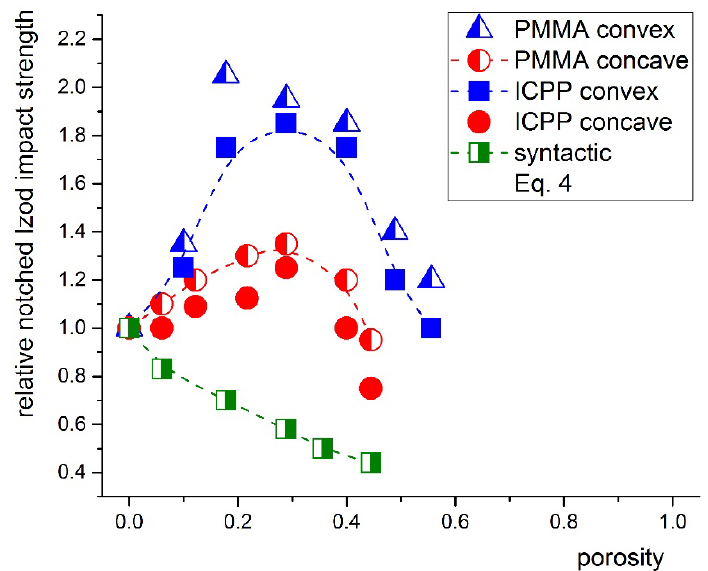
Figure 10. Dependence of the relative notched Izod impact strength on the relative porosity for the gradient porosity foams and commercial syntactic foams measured at room temperature and impact speed of 2.6 m/s. Dash lines serve as guides for the eye only.